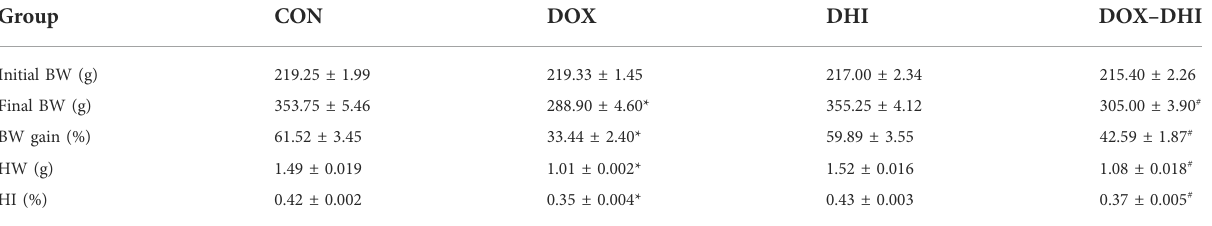
TABLE 1 Effect of DHI on DOX-induced changes in BW, HW, and HI. Group CON DOX DHI DOX – DHI Initial BW (g) 219.25 ± 1.99 219.33 ±